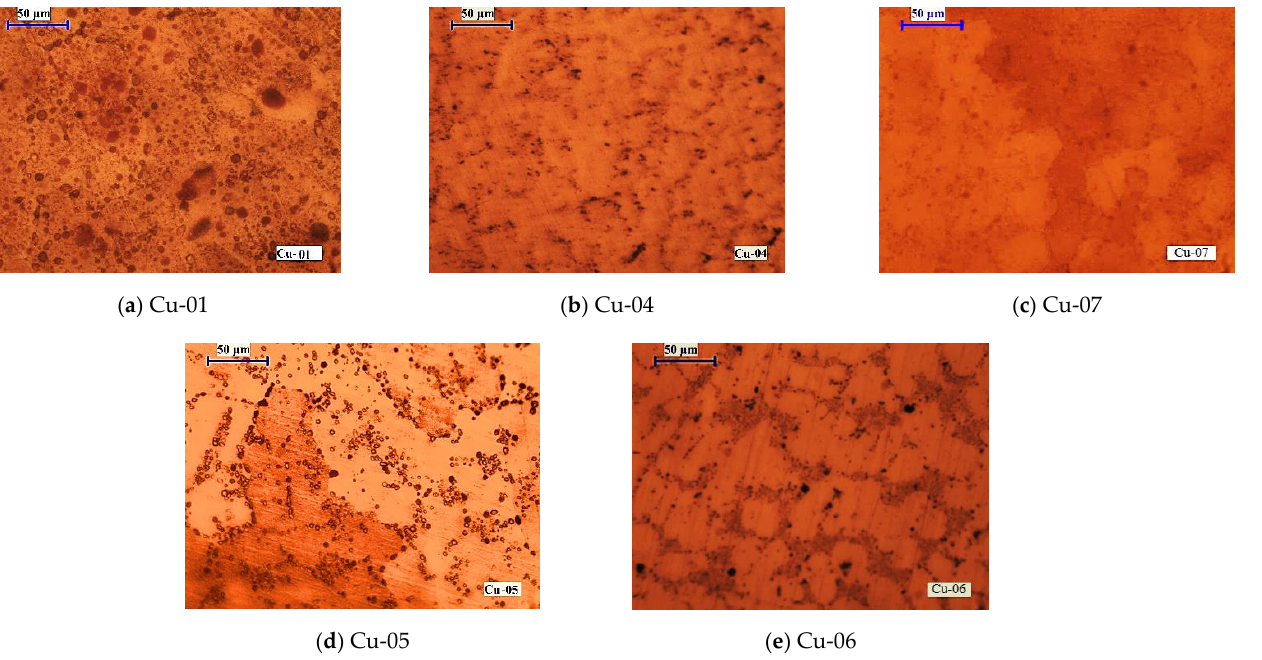
Figure 8. Macrostructures of copper samples manufactured at different EBMR conditions: ( a ) P b = 6 kW, τ = 20 min; ( b ) P b = 10 kW, τ = 20 min; ( c ) P b = 19.5 kW, τ = 20 min; ( d ) P b = 13 kW, τ = 20 min; and ( e ) P b = 13 kW, τ = 45 min.